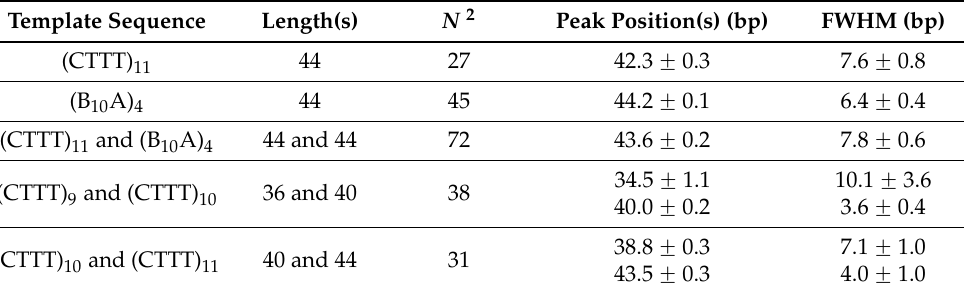
Table 2. Gaussian fitting parameters from length-counting